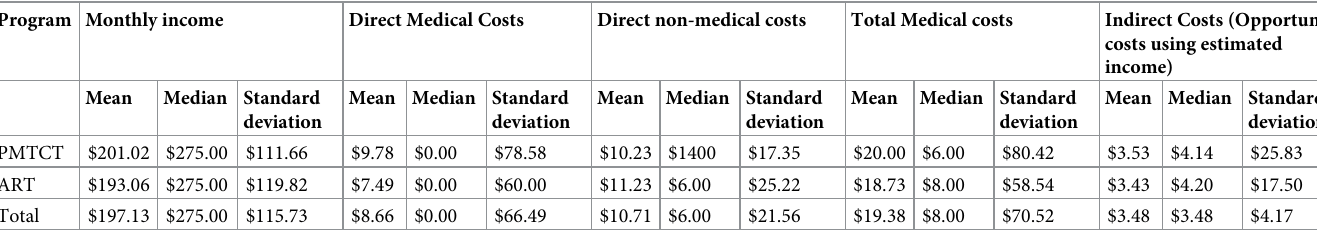
Table 5. Estimated average monthly income and disaggregation of costs by type of